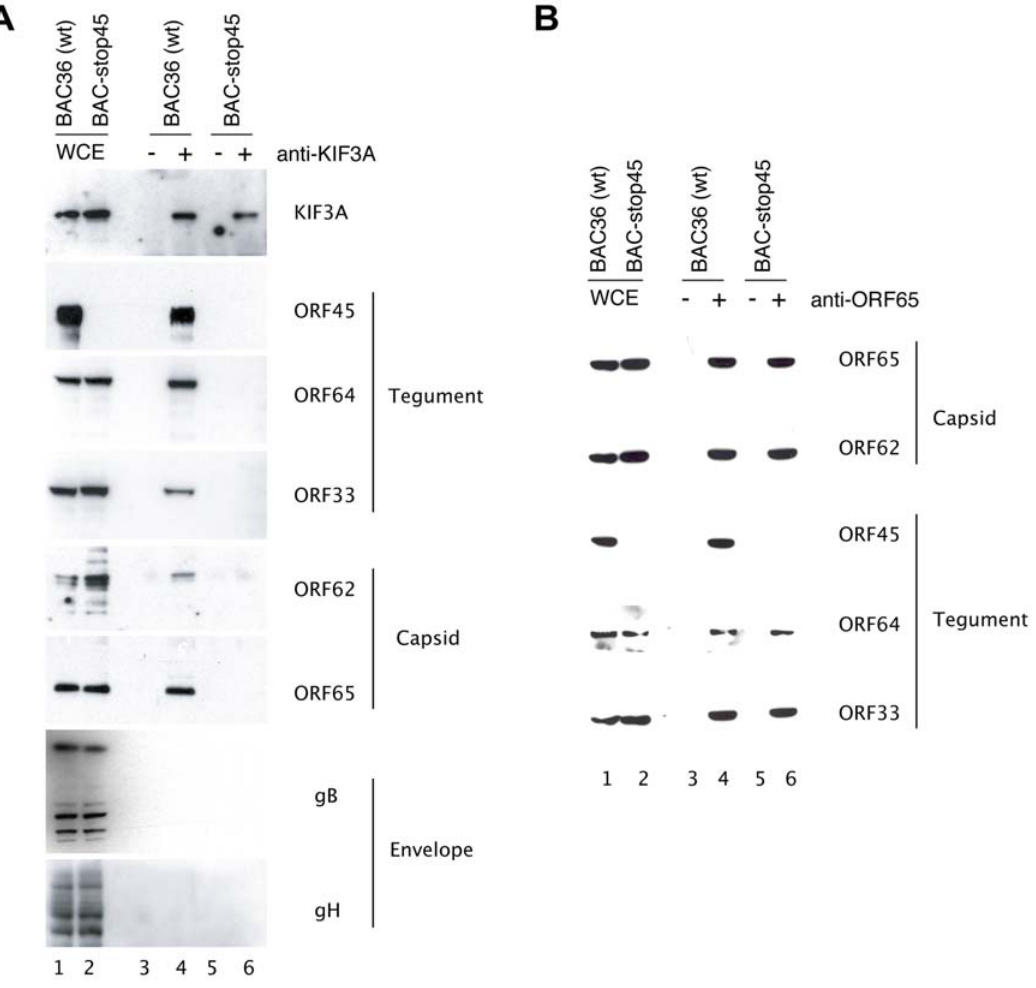
Figure 3. Association of KIF3A with KSHV capsid-tegument complexes mediated by ORF45. Stable 293T monolayers harboring either wild-type (BAC-36) or ORF45-null mutant (BAC-stop45) KSHV were induced with TPA for 48 hours. (A) Whole cell extracts (WCE) from both the BAC36 (lane 1) and the BAC-stop45 mutant (lane 2) were immunoprecipitated with rabbit IgG (lanes 3 and 5) or rabbit-polyclonal anti-KIF3A antibody (lanes 4 and 6). The immunoprecipitates were subsequently analysed by Western blotting with anti-KIF3A and antibodies to the KSHV virion tegument (ORF45, ORF33, and ORF64), capsid (ORF62 and ORF65) proteins, and envelope glycoproteins (gB and gH). (B) The same cell lysates were also immunoprecipitated with anti-ORF65 antibody, and the precipitates were analyzed by Western blotting with antibodies against different capsid and tegument proteins as indicated.